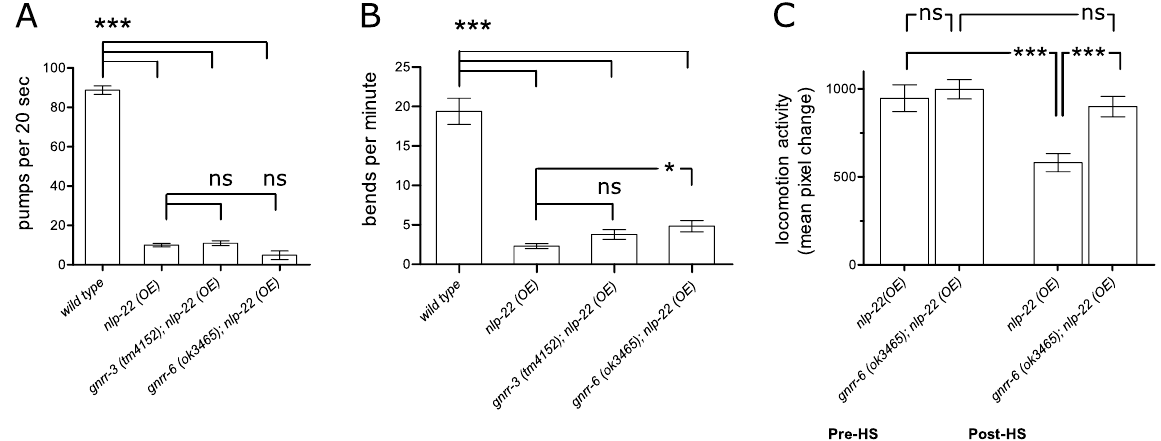
Figure 4. GNRR-6, but not GNRR-3, is required for nlp-22 induced locomotion quiescence. ( A , B ) Heat- shock induced overexpression of nlp-22 reduces both pharyngeal pumping ( A ) (N > 10 animals) and body bending ( B ) (N > 18 animals) compared to wild-type animals. These nlp-22 induced quiescence phenotypes are unaffected in gnrr-3 mutant animals. Overexpression of nlp-22 in gnrr-6 mutants attenuates locomotory activity, showing significantly more body bends, while nlp-22 induced feeding quiescence is still adequate in gnrr-6 mutants. ( C ) Long-term behavioral tracking before and after heat shock (HS) induction of nlp- 22 overexpression shows that gnrr-6 mutants display deficient movement quiescence compared to nlp-22 overexpression in wild-type animals (N = 24 animals). Error bars indicate SEM. One-way ANOVA and Tukey test; *** P < 0.001; * P < 0.05; ns, not significant ( P >